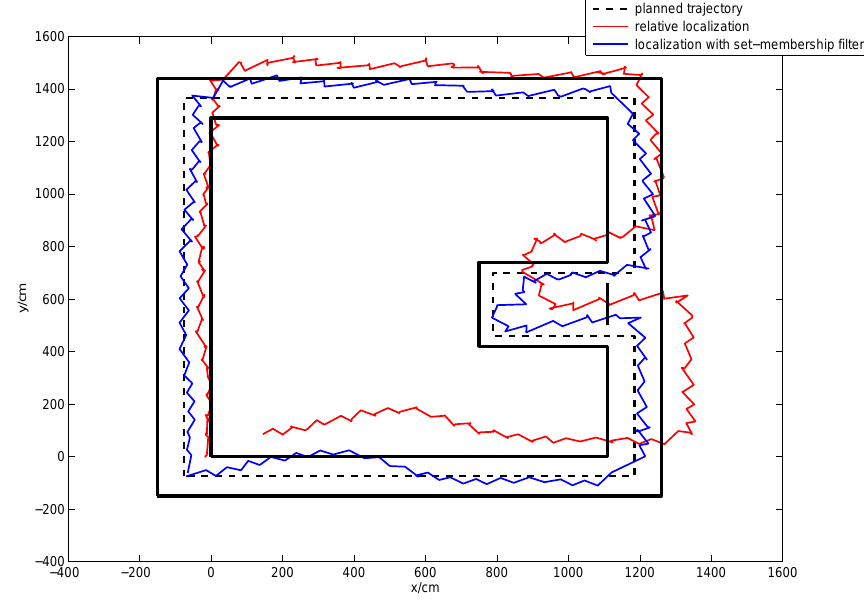
Figure 20. The average trajectory curves of subject A walking with small